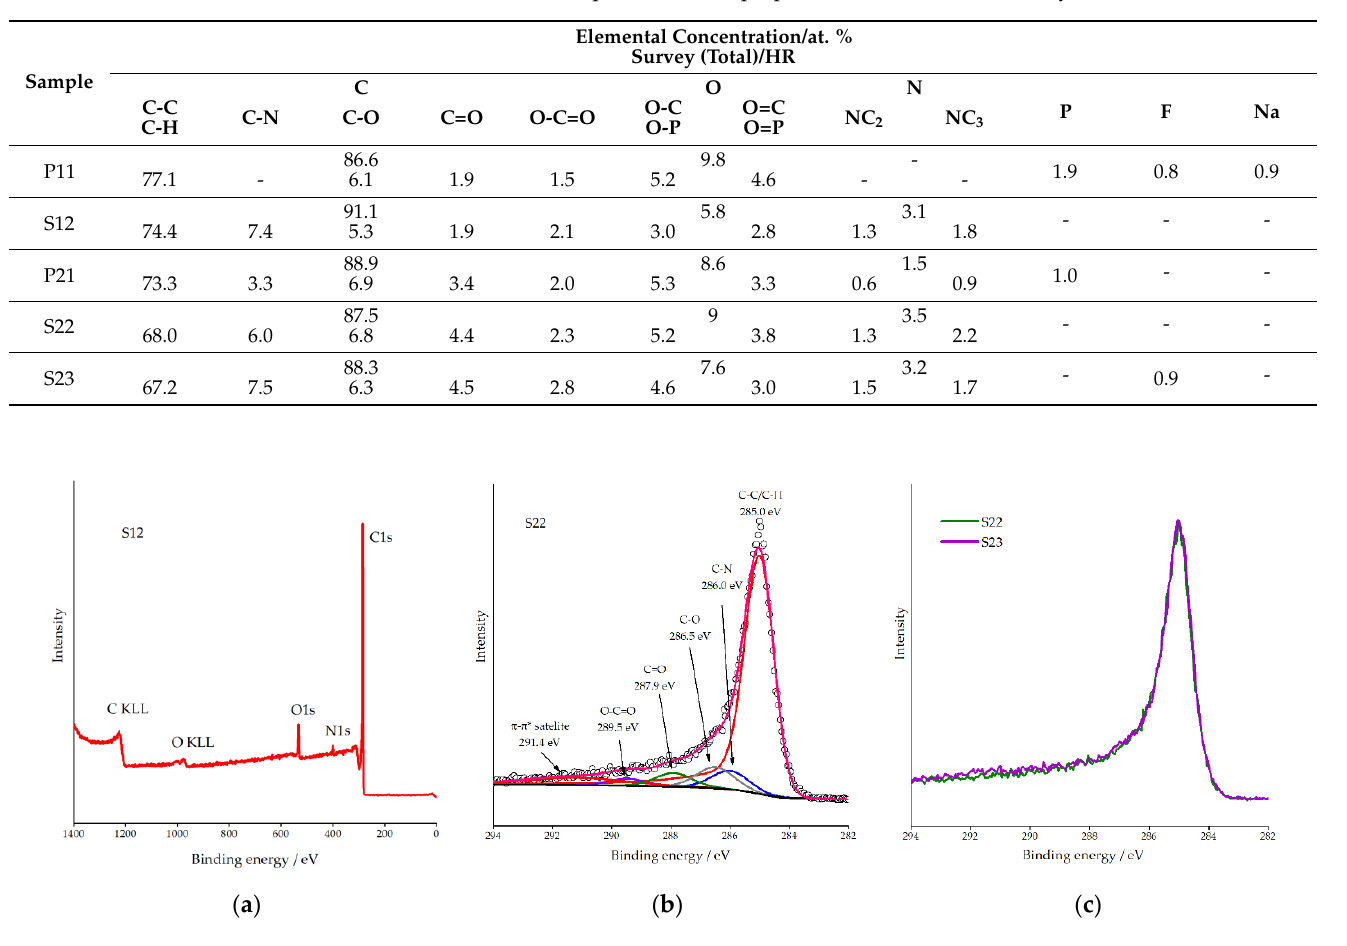
Figure 3. The results of the XPS analysis: ( a ) XPS survey spectrum of the ground sample S12; ( b ) chemical assessment of HR C1s spectrum of sample S22; ( c ) C 1s high resolution spectra of S22 and S23. Table 3. Elemental and chemical composition of the prepared CFs from the XPS analysis.